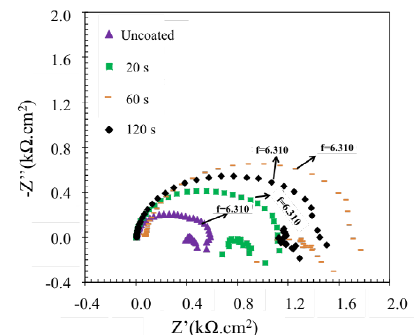
Figure 10. Nyquist plots of the uncoated and cerium-coated AZ91D alloy. Electrolyte: 3.5 wt.% NaCl solution at room